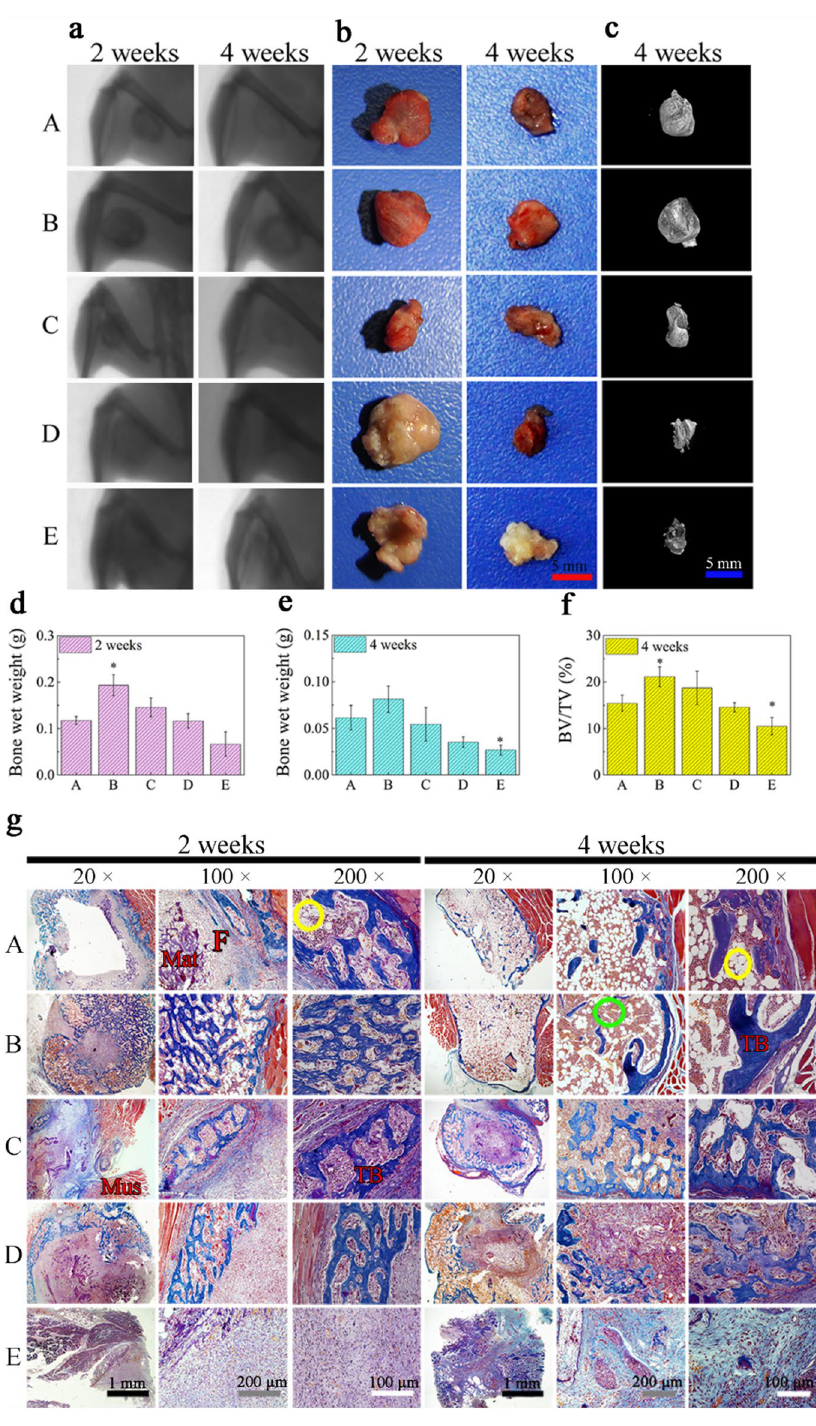
Figure 1. The correct version of Figure